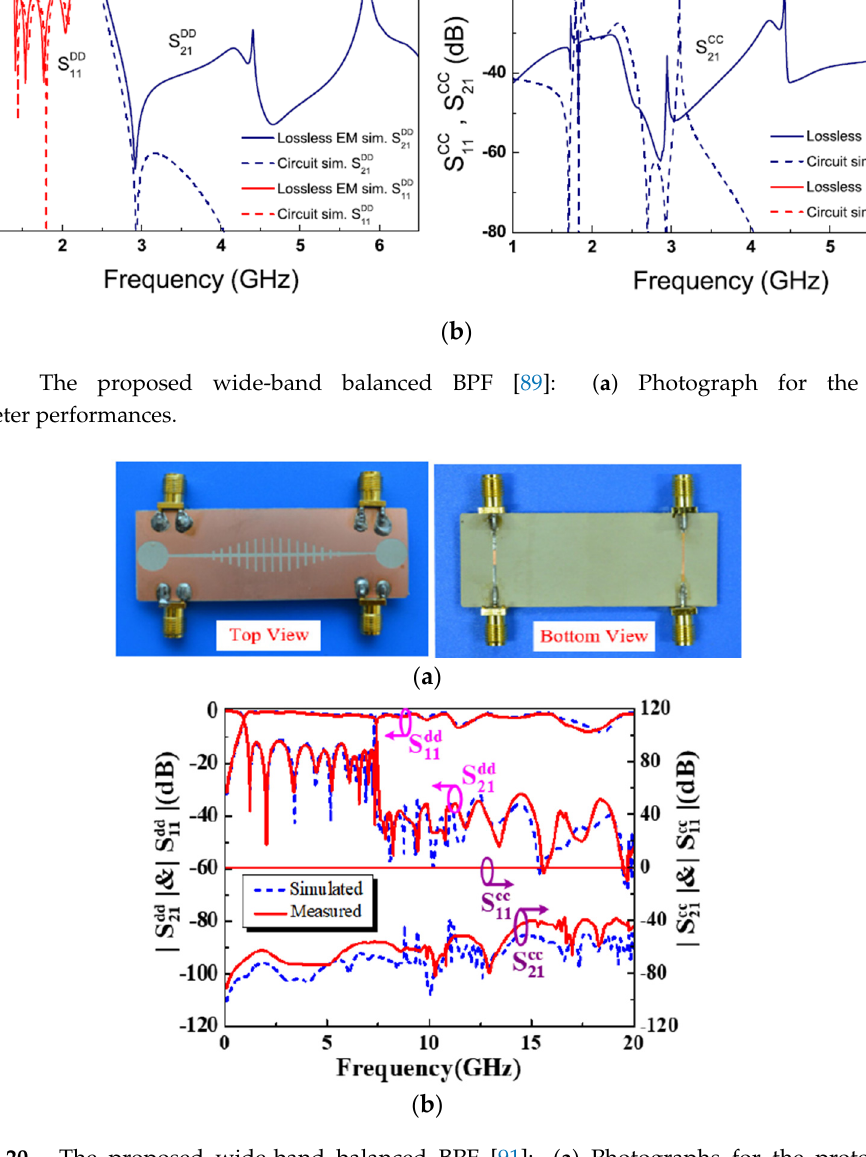
Figure 20. The proposed wide-band balanced BPF [91]: ( a ) Photographs for the prototypes; ( b ) S- parameter performances. ( b ) S-parameter